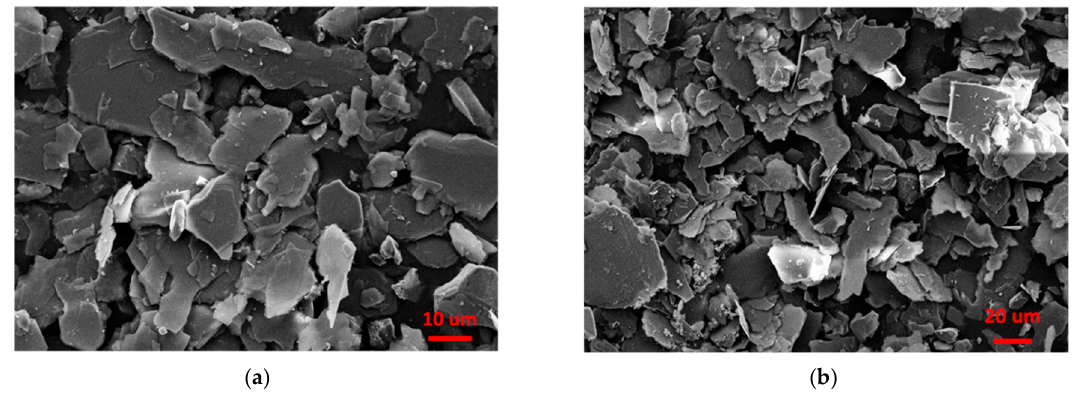
Figure 1. XRD patterns of S0 and S3.